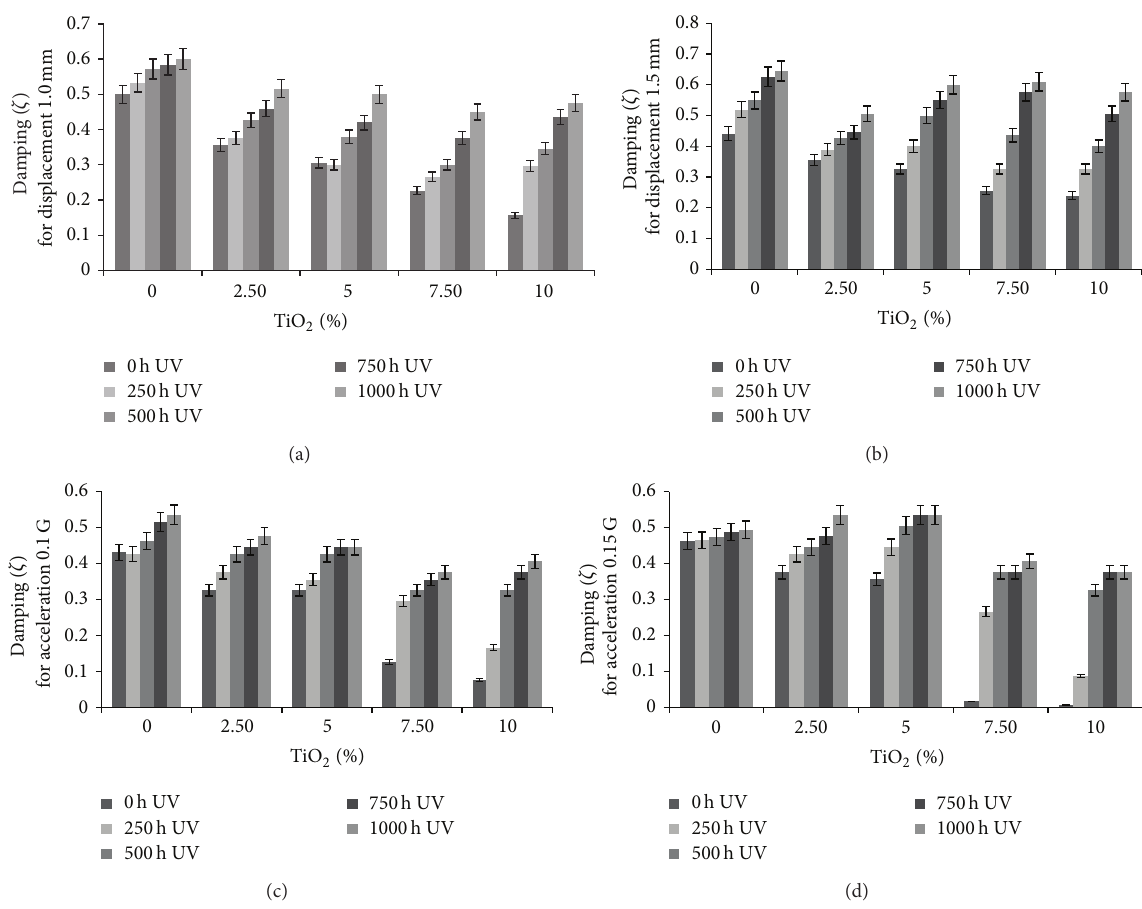
Figure 11: Damping of CBC samples: (a) 0.15G and (b) 0.1G and (c) 1mm and (d) 1.5 mm base excitation of 10mm thickness with TiO 2 with UV